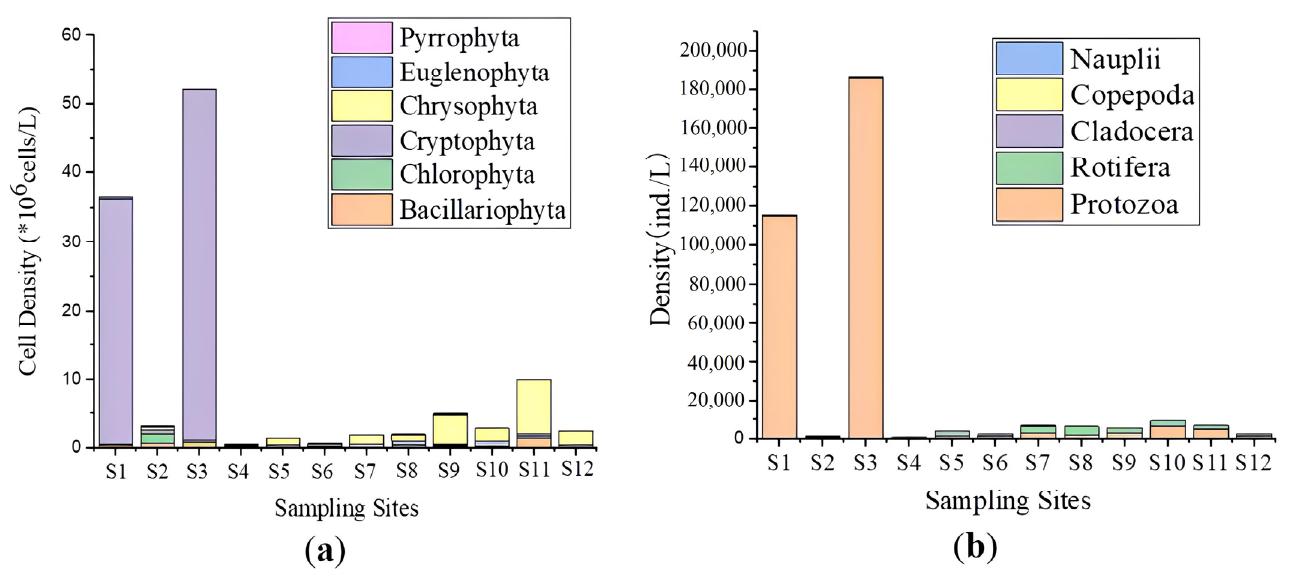
Figure 2. Spatial distribution of plankton abundance in the sampling points. Total density of ( a ) Phytoplankton, ( b ) Zooplankton.